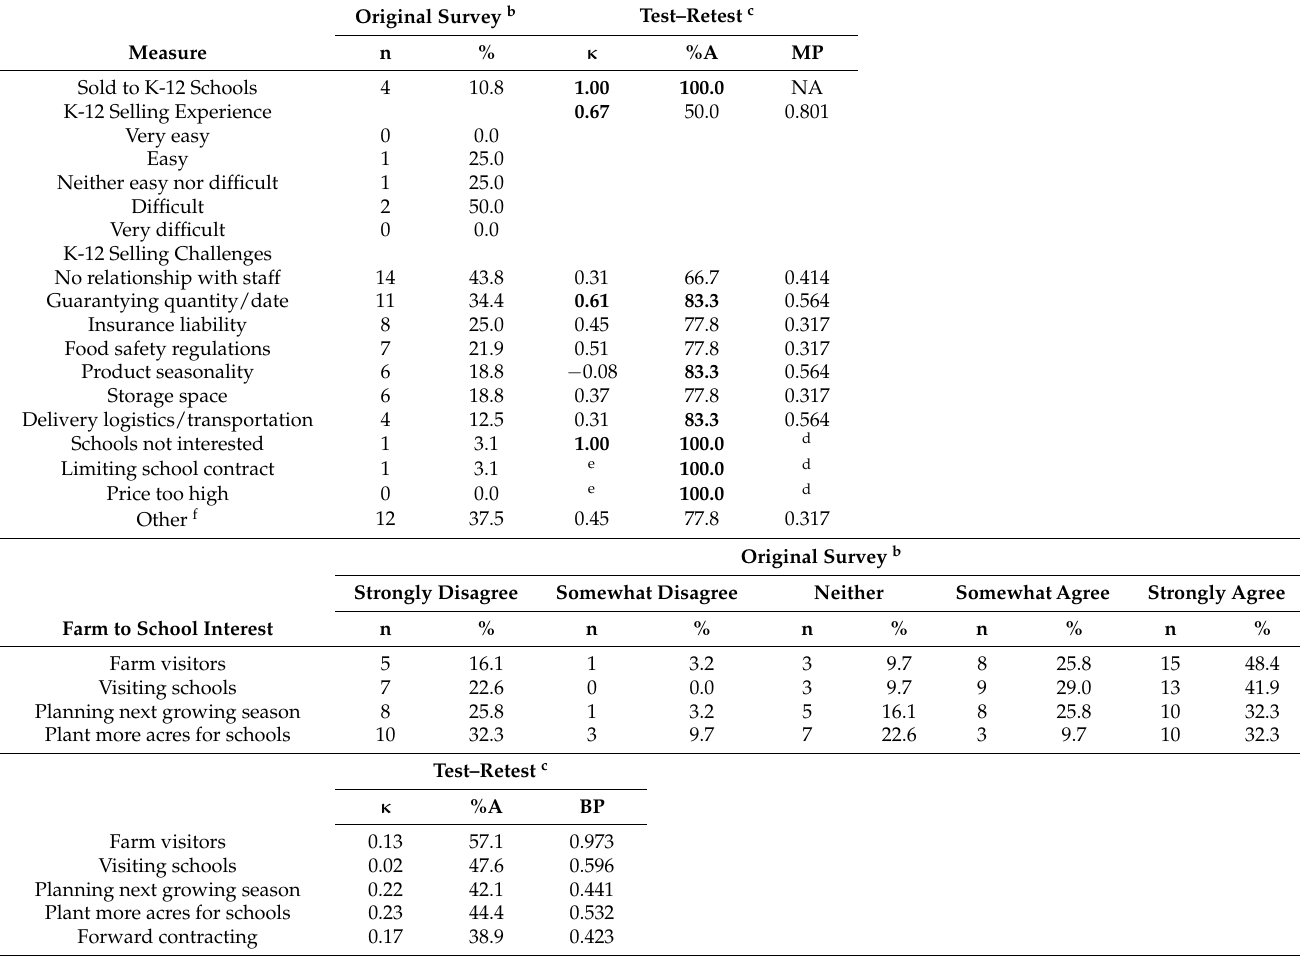
Table 3. Farm to School Experience and Interest with Test–Retest Statistics a : Mississippi Farm to School Small Farmer Survey